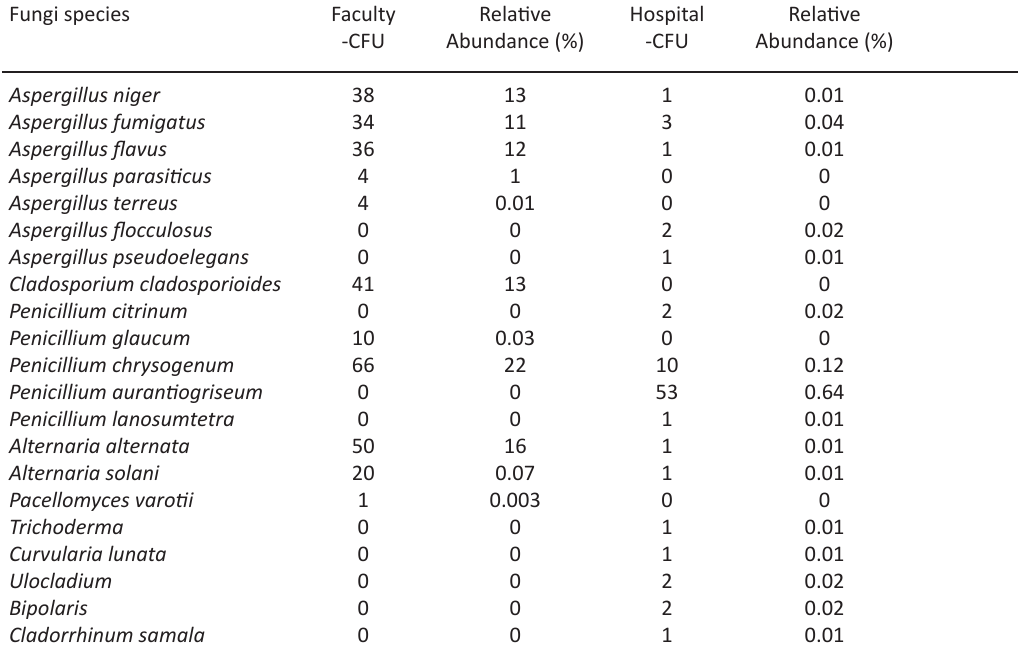
Table 2. Relative abundance depending on colony forming unit CFU for both fungi populations from Faculty and Hospital laboratories Fungi species